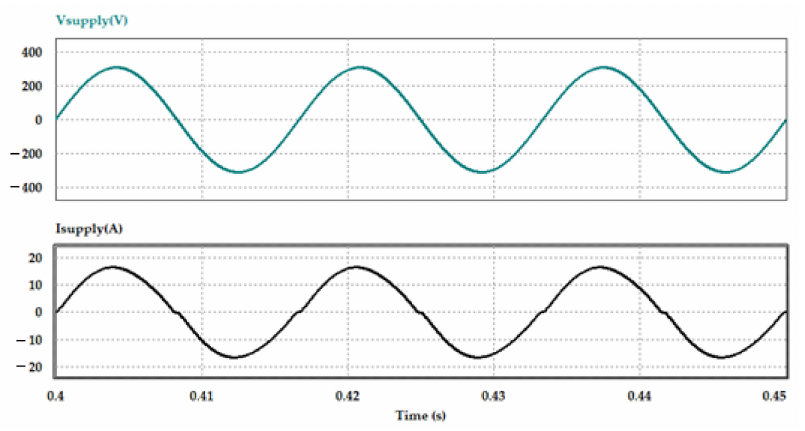
Figure 30. Waveforms of the supply current-voltage with the proposed IP current controller.